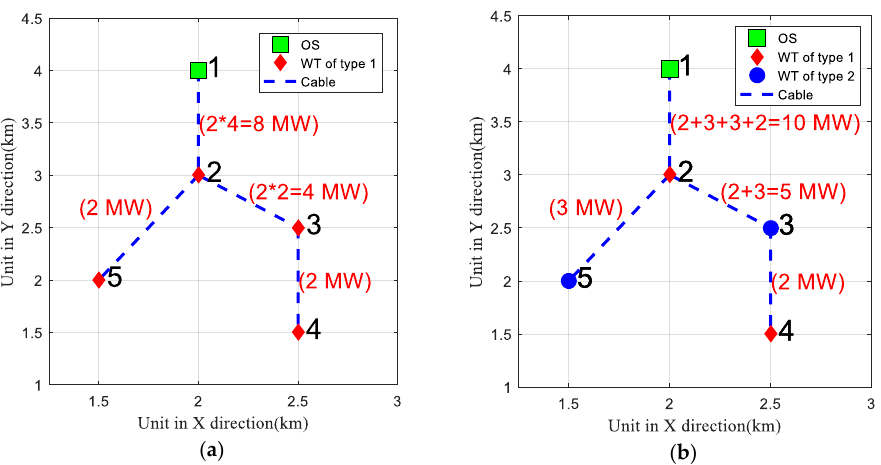
Figure 1. A simple example of Energy calculation when all WTs are operated in full load condi- tion. ( a ) Energy distribution for the homogeneous wind farm; ( b ) Energy distribution for the